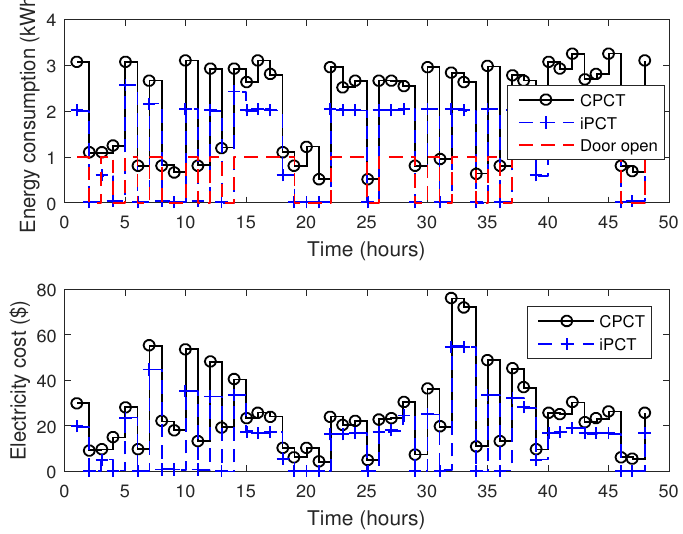
Figure 12. Total energy consumption and electricity cost of refrigerator w.r.t number of door opens ( t = 30 min time